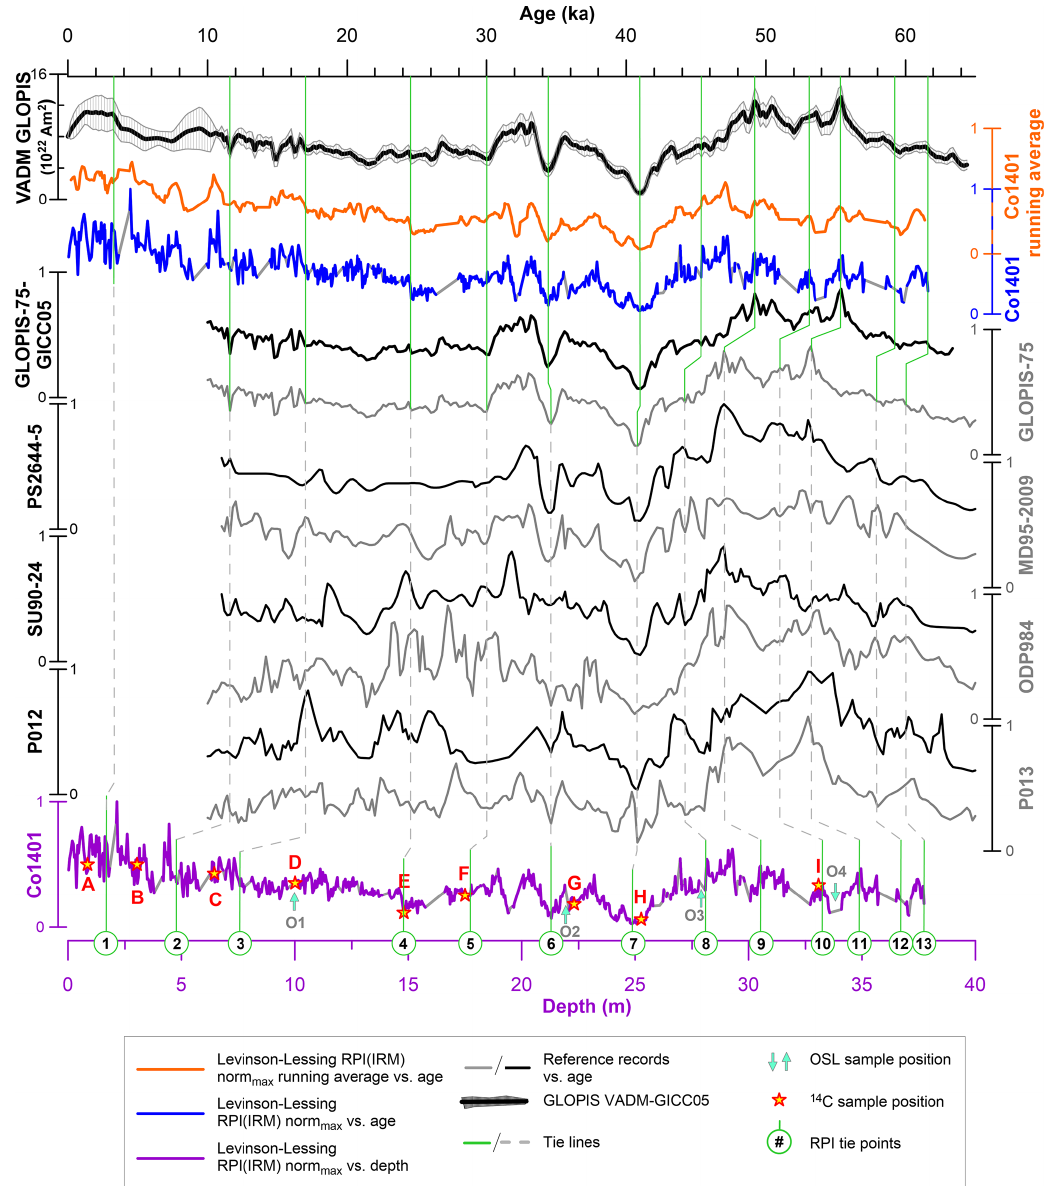
Figure 7. Tuning of the RPI(IRM) of Co1401 to six northern individual records of GLOPIS-75, and the GLOPIS-75 stack. Names of RPI records are given as axis labels. Please see Sect. 3.4 for references. Please note age divergence between GLOPIS-75 and GLOPIS-75- GICC05. Running average of RPI(IRM) of Co1401 vs. age calculated with window width of 5 is shown for better identification of the general trend. All RPI datasets are normalized to the individual maximum